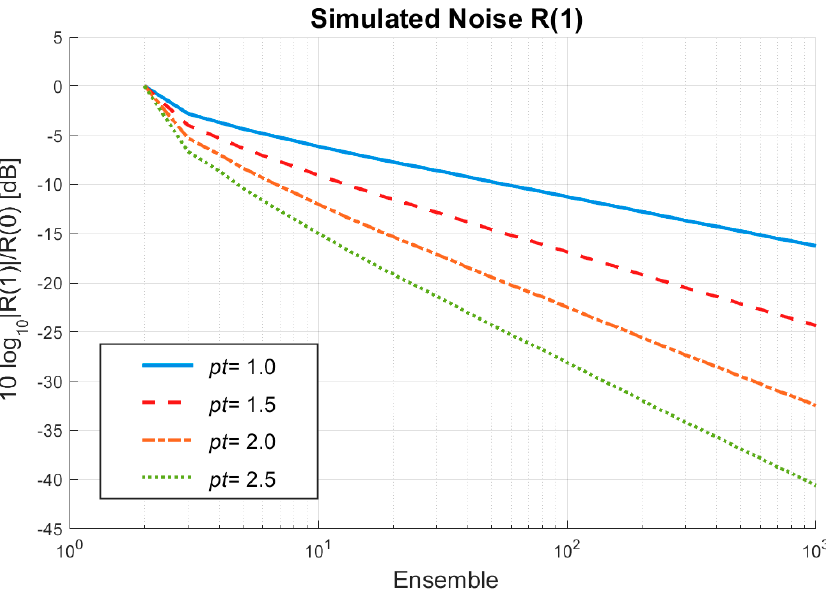
Figure 6. Simulated noise level as a function of the ensemble number for the pt values of 1.0, 1.5, 2.0